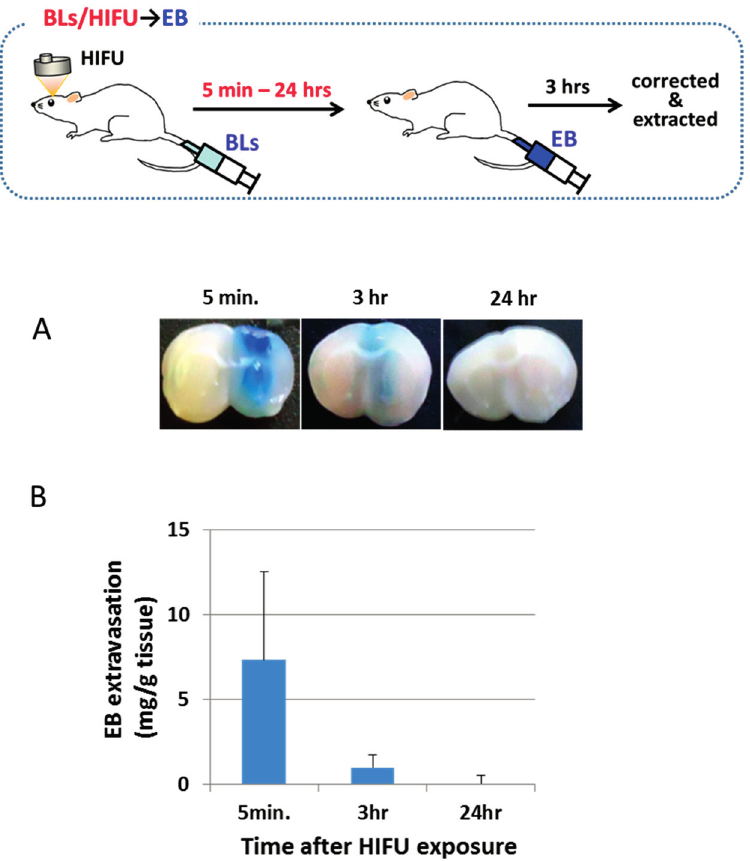
Figure 2. EB extravasation in the right brain (HIFU-exposed site) as a function of time after HIFU exposure. ( A ) Distribution of the BBB indicated by the extravasation of EB. Right brain: HIFU-exposed site. Left brain: control (non-exposed site). ( B ) The amount of EB extravasation in the right brain. The mice were injected into the tail vein with Bubble liposomes (100 μ g/mouse) and exposed to HIFU with 3.5 MHz, 10% duty, 1.5 kw/cm 2 , and 60 s. After a definite period of time (5 min to 24 h), each mouse was injected with EB (100 mg/kg). After three hours, the right brain was corrected. Each value represents the mean S.D. ( n = 4). EB: Evans blue, BL: Bubble